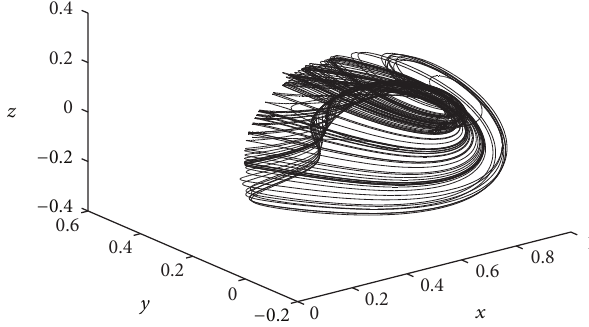
Figure 1: The chaotic attractor of system (2).